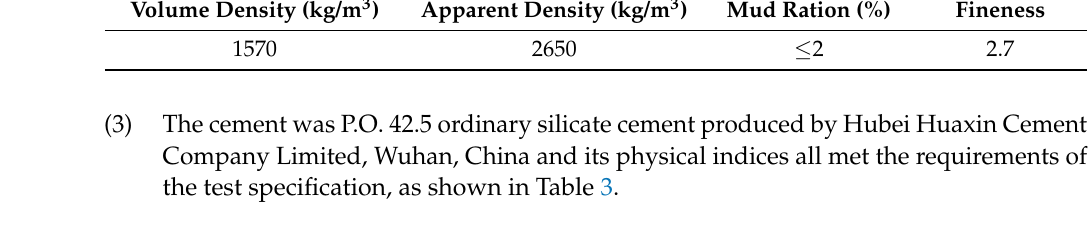
Table 3. Basic physical index of